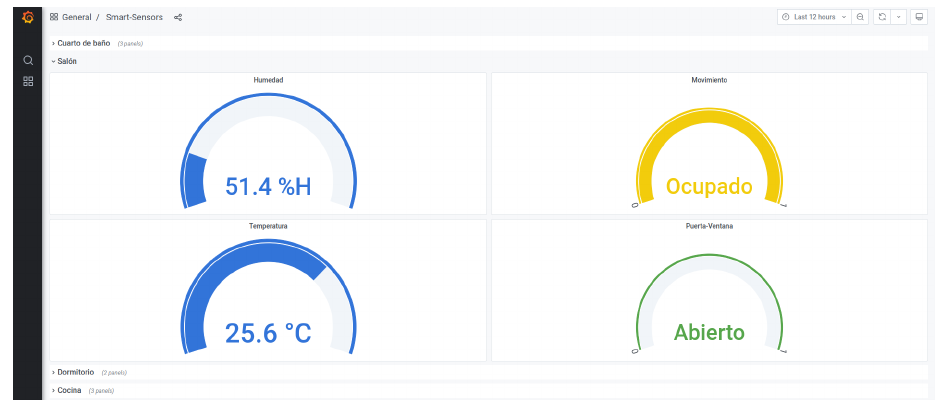
Figure 28. Dashboard for environment